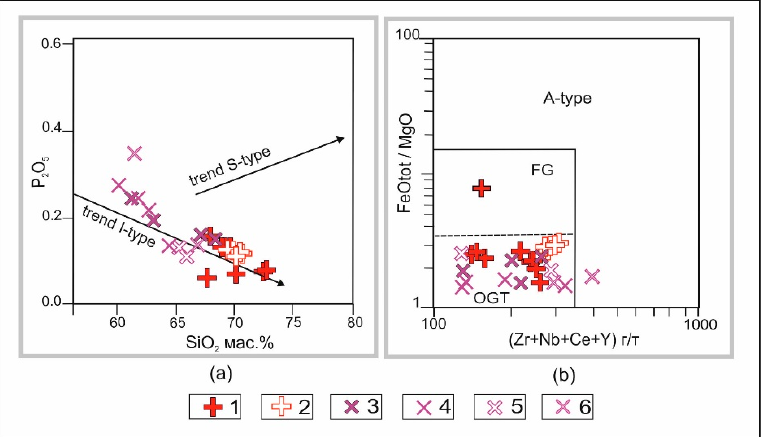
Figure 3. Diagrams for the determination of the petrogeochemical type of granitoids of the EF MOOB framing: ( a ) P 2 O 5 /SiO 2 petrochemical type trends by [29]. ( b ) FeO tot /MgO − Zr + Nb + Ce + Y [30], fields of the rocks: FG-fractioned and OGT-not fractioned M-, I-, S-types; A-type. Legend: granitoids of the adakite series of southern framing (1), of northern framing (2); of the calc-alkaline plutonic series of southern framing (3), of northern framing (4); of the calc-alkaline series hypabyssal of southern framing (5), of northern framing (6).